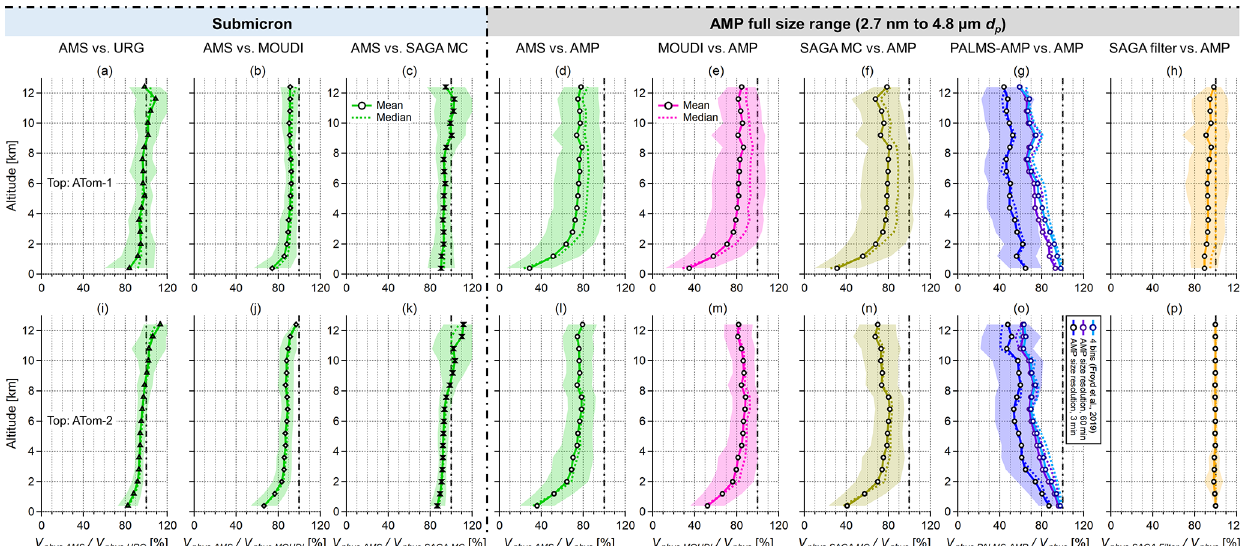
Figure 9. Comparison of the fraction of the particle volume that is observable (i.e., those contributing chemical composition information but independent of the properties of the chemical detector) between instruments or inlets as a function of altitude, for the conditions in (a– h) ATom-1 and (i–p) ATom-2. (a–c, i–k) The widely used approximate submicron cuts are compared. (d–h, l–p) The ATom aerosol payload is compared, including a MOUDI 1µm impactor that has been flown in other studies. The color-shaded area indicates the SD of volume